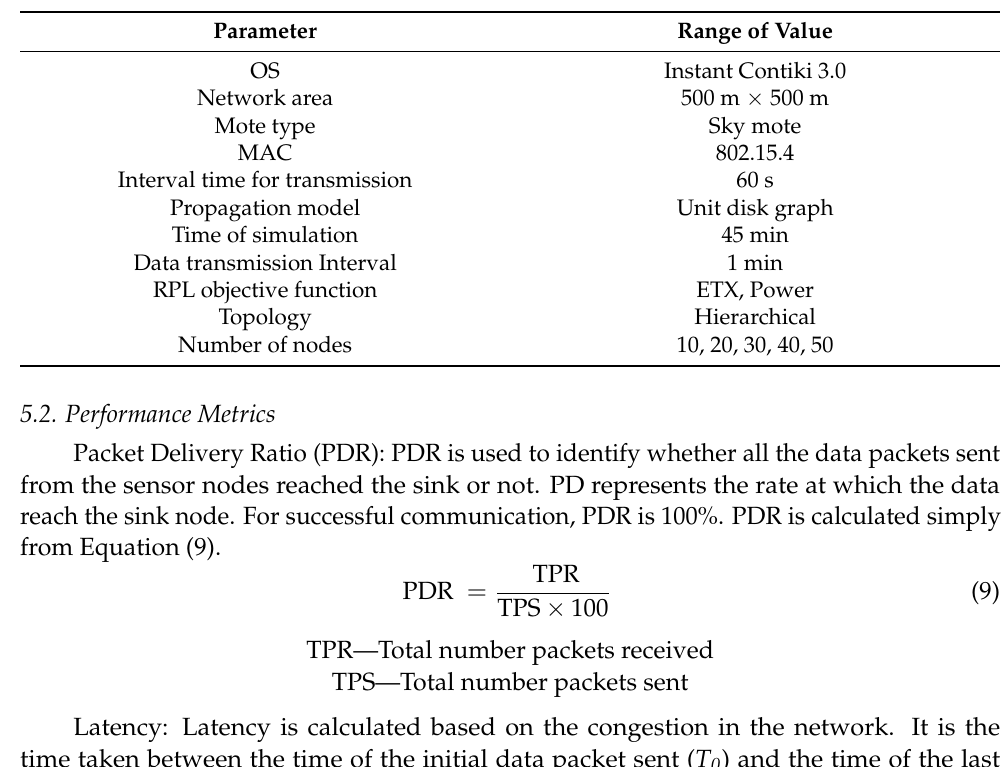
Table 1. Simulation